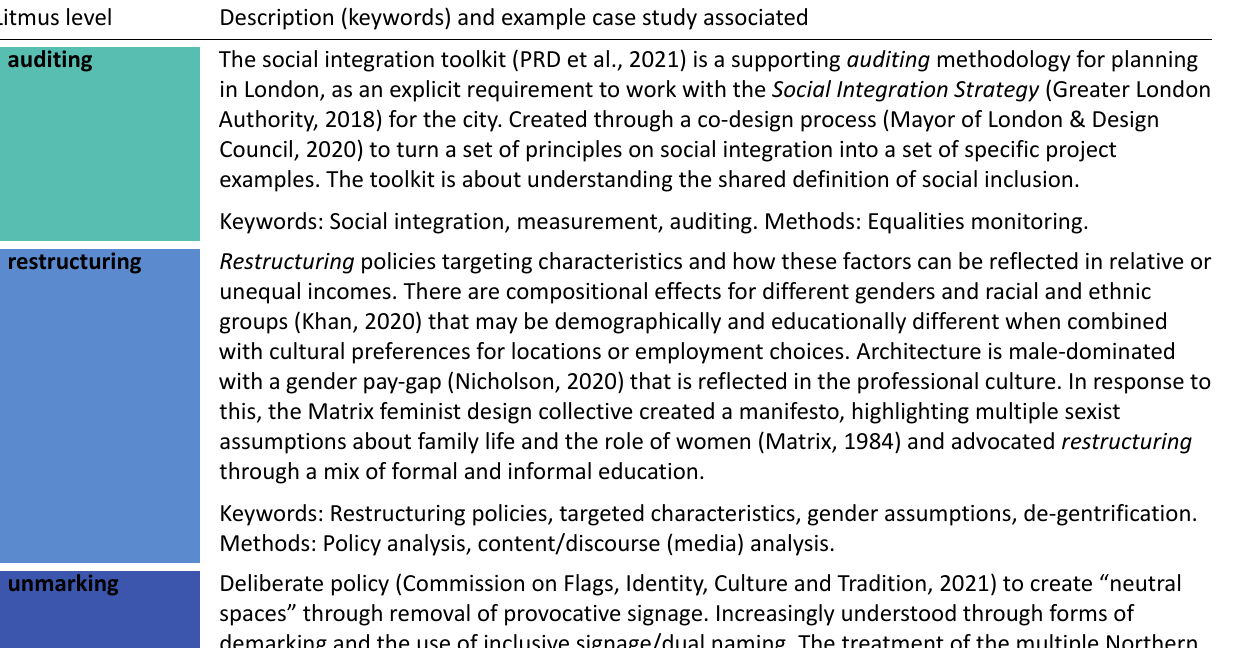
Table 3. (Cont.) Definitions of positive interventions to segregation and inequalities. Litmus